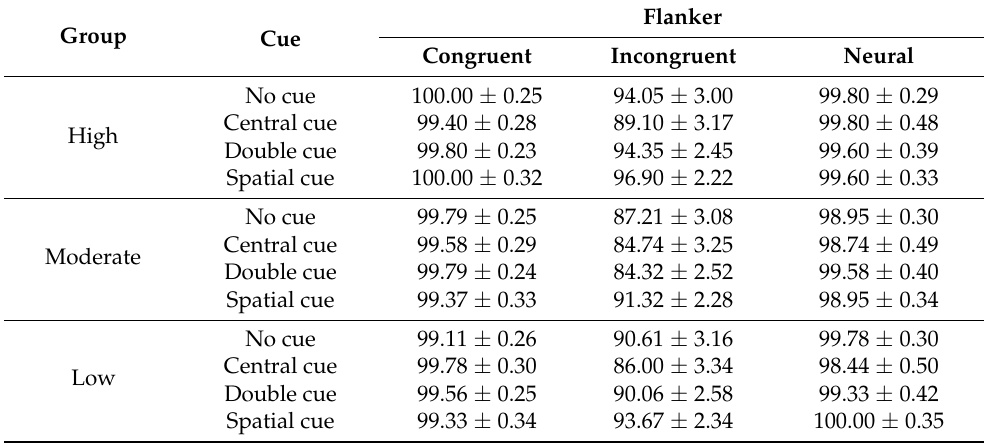
Table 3. Mean accuracy rates on the Attention Network Test for groups with high, moderate, and low physical activity (mean ± standard